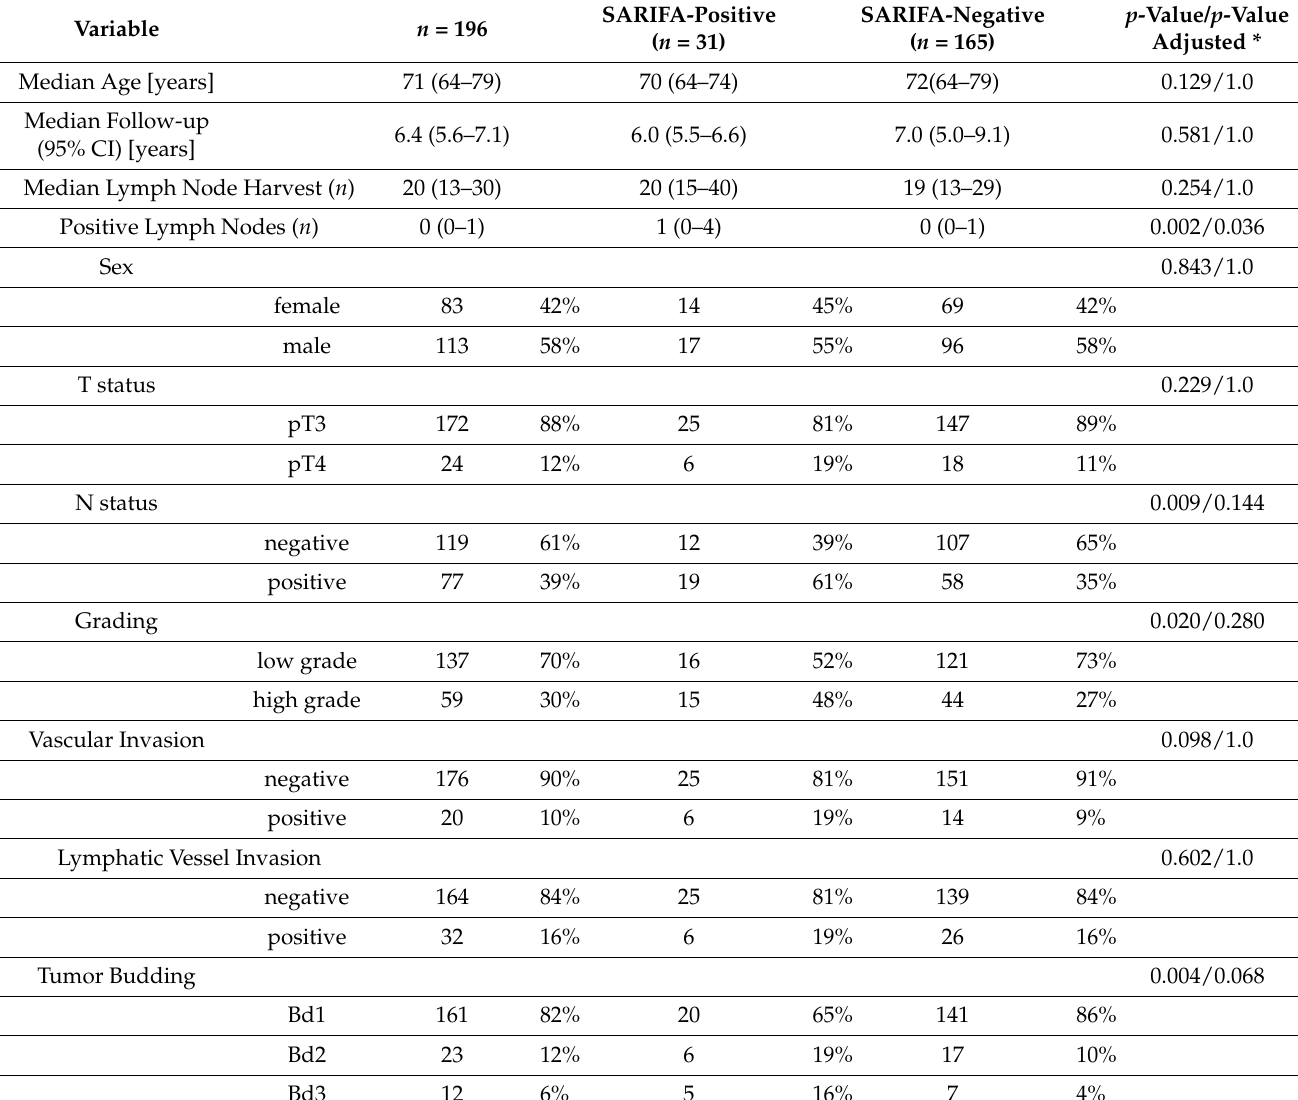
Table 1. Clinicopathological characteristics group